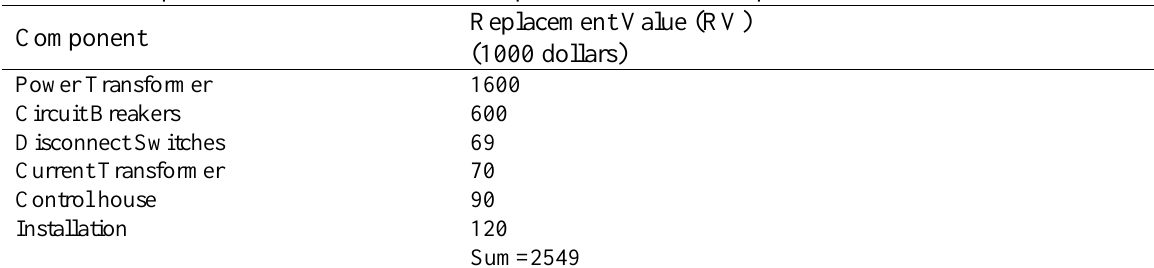
Table 13. Replacement values of the studied power substation components in Iran